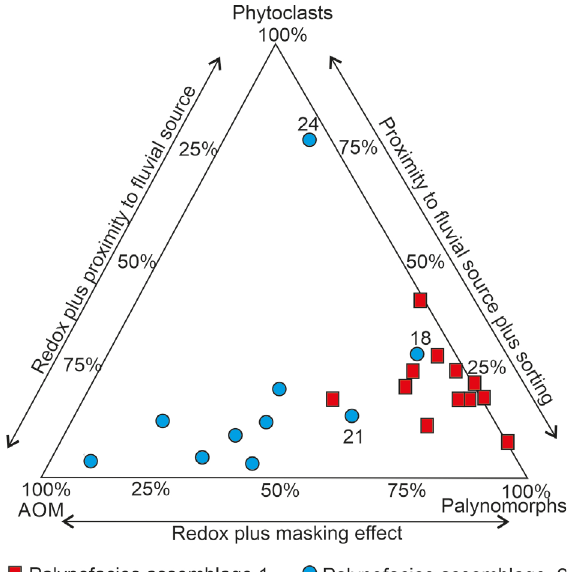
Figure 13. Ternary plot AOM-Phytoclast-Palynomorph based on relative frequency kerogen from Snow Island (Adapted from Tyson 1993,